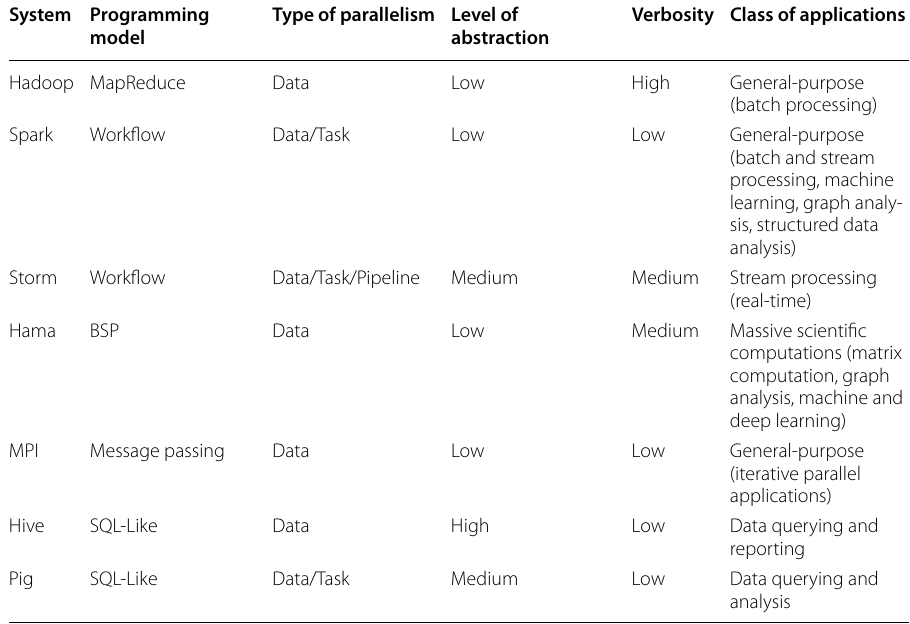
Table 1 Features of the systems System Programming Type of parallelism Level of Verbosity Class of applications model abstraction Hadoop